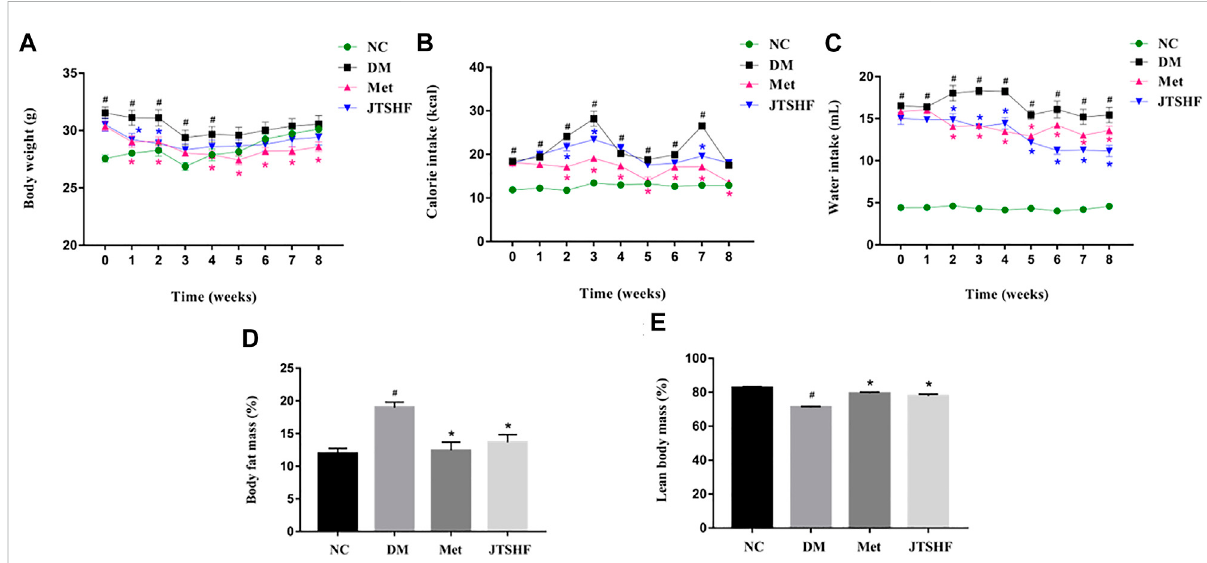
FIGURE 2 JTSHF reduced calorie and water intake and improved body composition in diabetic mice. (A) Body weight of mice. Alteration in (B) calorie intake and (C) water intake during intervention. (D) Body fat mass and (E) lean body mass of mice after treatment. All Values were expressed as mean ± SEM. # p < 0.05 versus NC group, * p < 0.05 versus DM group; n = 8 for each group in A – E. Time in A – C means time of drug administration. The calorie intake of each mouse was calculated by the following formula: calorie intake in normal mice = food intake/g × 3.1 kcal/g, calorie intake in HFD-STZ induced diabetic mice = food intake/g × 5.24 kcal/g.